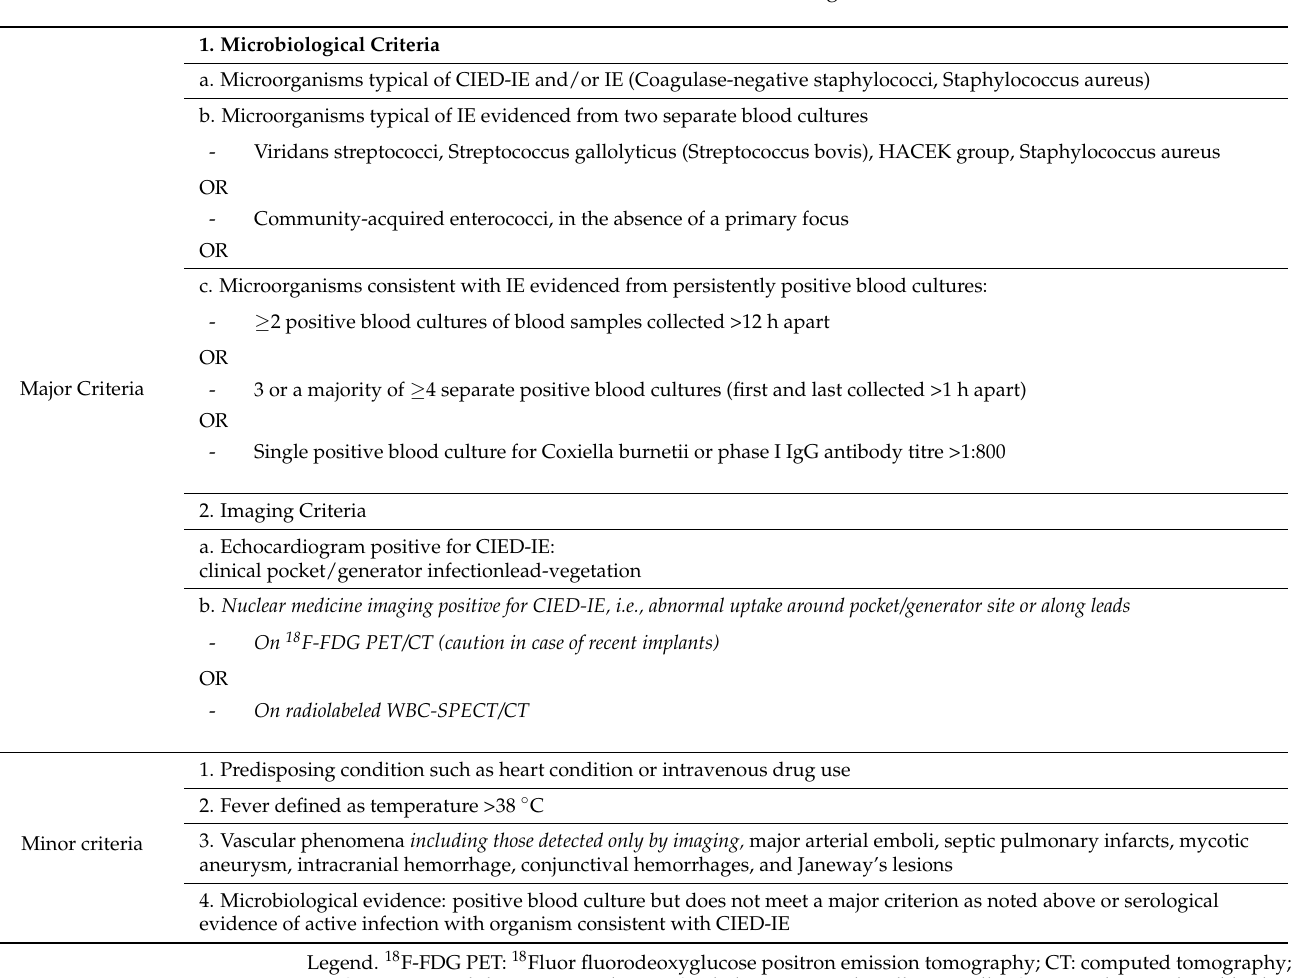
Table 4. Novel 2019 International Criteria for the diagnosis of